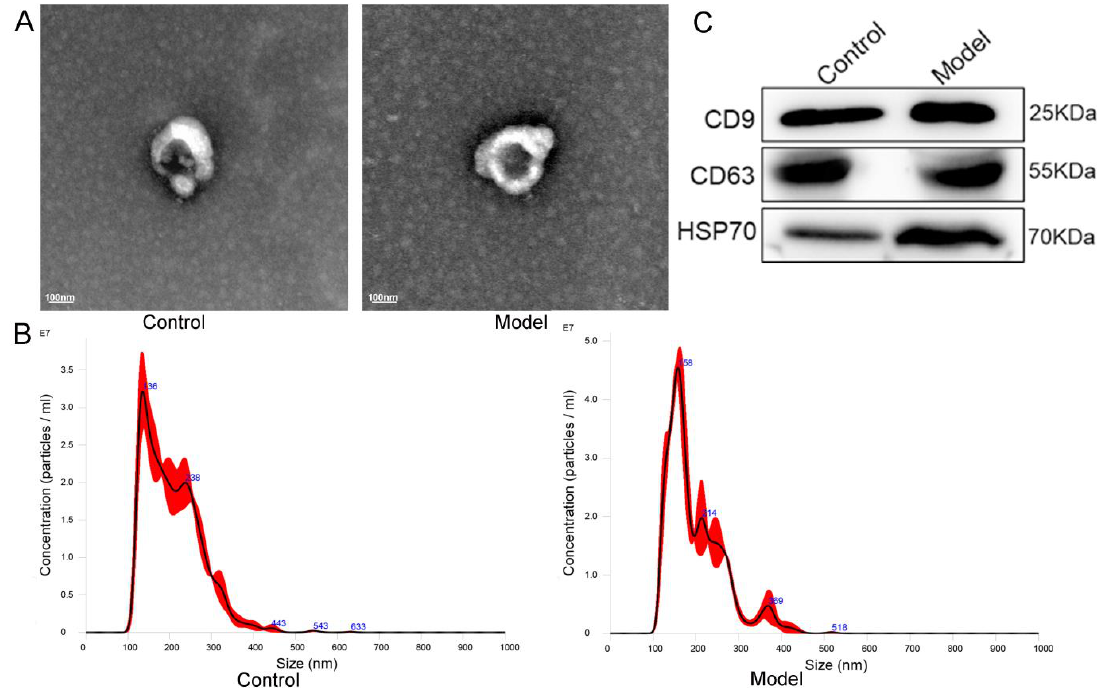
Figure 2. EVs were isolated using differential centrifugation and identified using TEM, NTA, and WB. ( A ) TEM observation of the EV morphology. ( B ) NTA measurement of the EV particle distribution and concentration. ( C ) WB analysis of the EV markers CD9, CD63, and HSP70.